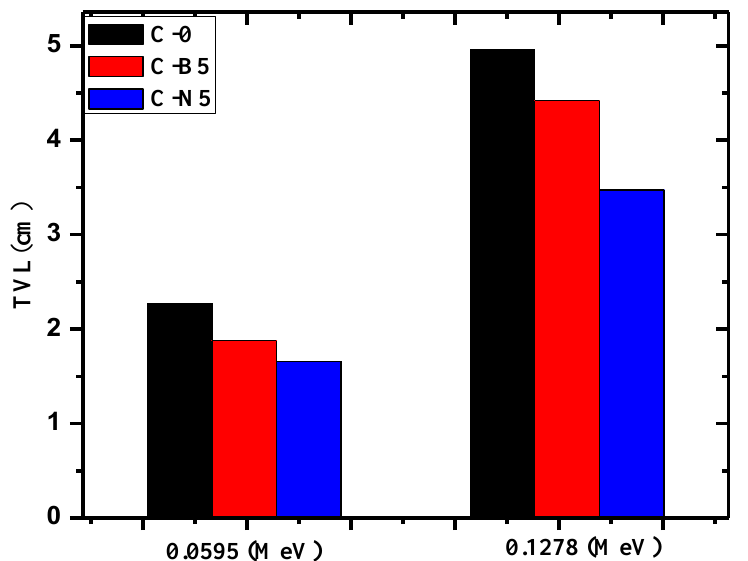
Figure 8. The tenth-value layer for the C-0, C-B5 and C-N5, at 0.059 and 0.1278 MeV. The radiation protection efficiency (RPE) of the prepared concretes were graphed against increasing energy in Figure 9. First, it can be seen that RPE decreases with increasing energy for all five samples. For example, C-0 (cid:48) s RPE decreases from 63.3% at 0.060 MeV to 13.48% at 1.408 MeV and C-N15 (cid:48) s RPE decreases from 87.9 to 15.09% for the same respective energies. This decreasing trend occurs due to the increased penetration power of higher energy photons, which decreases the capability for these concretes to shield the incoming radiation. When comparing the values against each other, it can be seen that the RPE results follow the order of C-0 < C-B5 < C-N5 < C-N10 < C-N15. At 0.344 MeV, for example, the RPE values are equal to 24.41, 25.08, 27.39, 28.84, and 30.93% for C-0, C-B5, C-N5, C-N10, and C-N15, respectively. These results indicate that adding Bi 2 O 3 to the concretes improve their shielding ability. Additionally, C-N5 has a greater RPE than C-B5, this result demonstrates that Bi 2 O 3 NP are more efficient at shielding radiation than bulk Bi 2 O 3 . As the Bi 2 O 3 further increases, the RPE values increase with it, meaning that increasing the Bi 2 O 3 content in the concrete enhances the attenuation capability of the